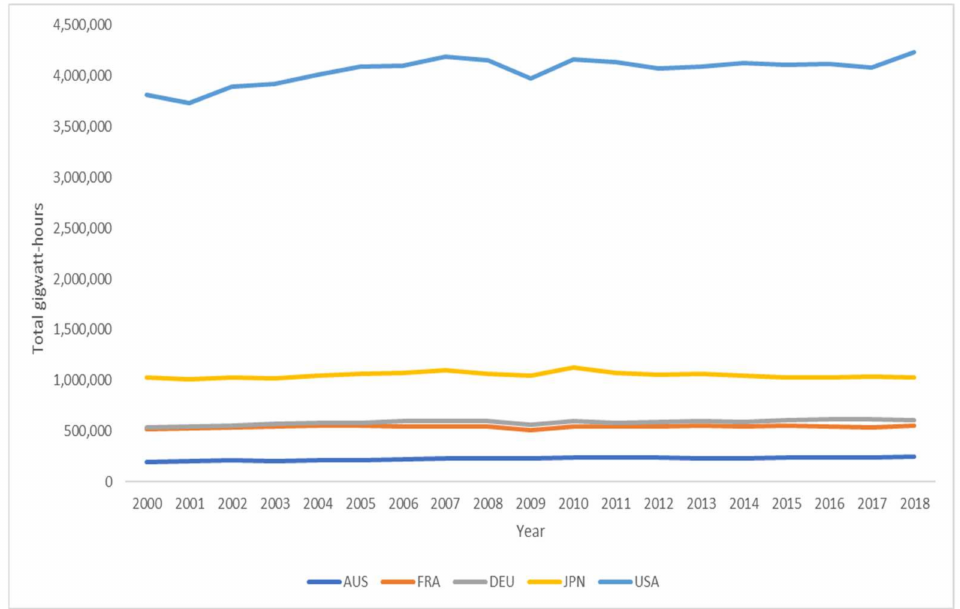
Figure 4. Total electricity generation in selected OECD countries (2000–2018). Source: own results based on